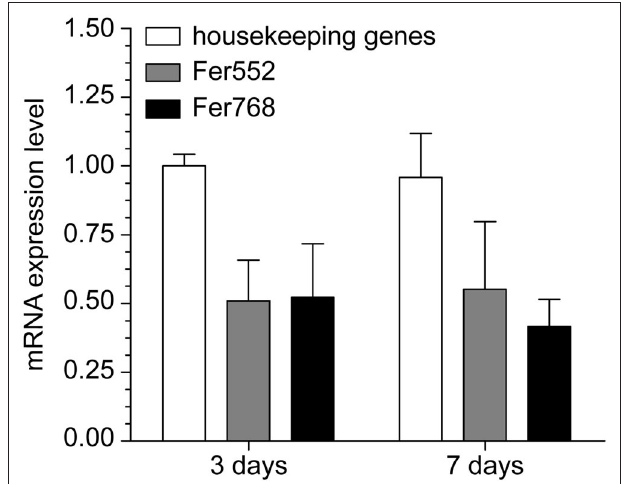
FIGURE 3 | Rice gene expression levels determined using reverse-transcription quantitative-PCR. The levels of mRNA that code two ferritins exhibited differential expression in rice roots inoculated with Herbaspirillum seropedicae . Fer552 corresponds to similar to ferritin 1, chloroplast precursor (EC 1.16.3.1) (ZmFer1), RAPDB Os11t0106700-01, primers forward 5 ′ CCGCCGCCGCCGCGCCTACC 3 ′ and reverse 5 ′ CCTT CCCTTTCCCGGCGGCC. Fer768 corresponds to similar to ferritin 1, chloroplast precursor (EC 1.16.3.1) (ZmFer1), RAPDB Os12t0106000-01, primers forward 5 ′ ATTCCTTGAGGAGCAGGTTG 3 ′ and reverse 5 ′